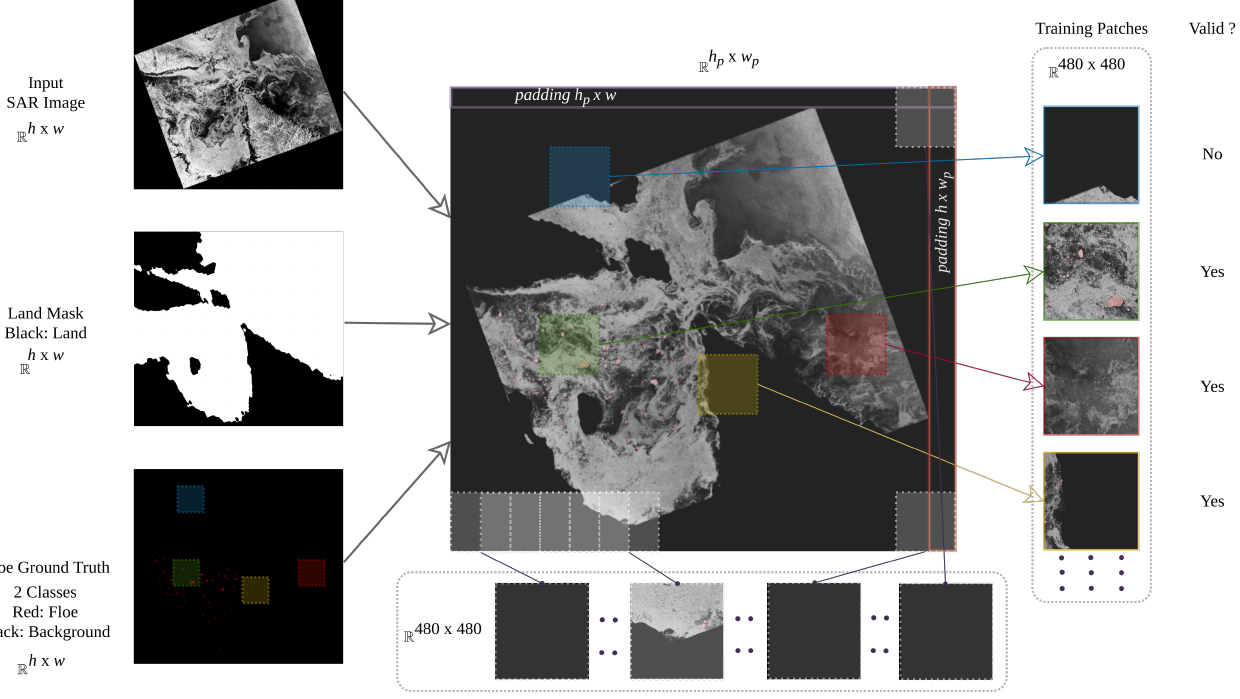
Figure 2. Patch generation for training, validation, and testing. Training: input SAR image ( h × w ) is land masked and patches of size 480 × 480 are selected randomly from the image. For a patch to be considered as a valid training sample, it should not contain more than 50% black pixels. Validation and testing: land masked SAR image is padded using black pixels. Patches are drawn serially from the land masked SAR image with a patch overlap of 50%. Total training/validation patches extracted from an image are ( h p × w p ) ÷ ( 480 × 480 ) . Image acquired on date 2012-06-06 at time 10:44:18 along the Canadian east coast with central coordinate 60°42 (cid:48) 8 (cid:48)(cid:48) N, 65°1 (cid:48)